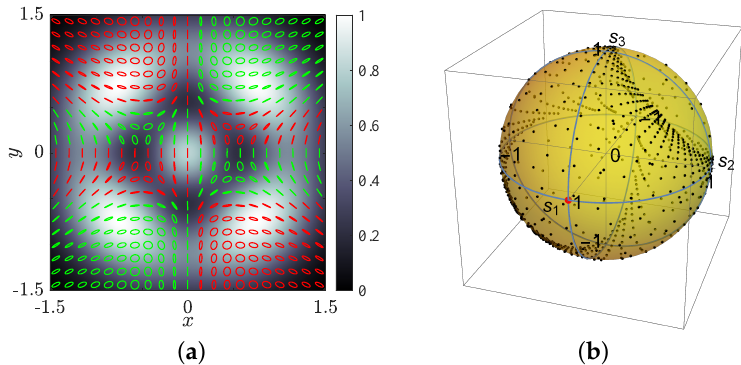
Figure 2. ( a ) Transverse intensity and polarization pattern for the field in Equation (10) where handedness is codified by the color of the ellipses (green = right, red = left, and red is also used for linear polarization), and distances are normalized to the beam spot size; ( b ) corresponding states of polarization represented by black dots on the Poincaré sphere; the red dot indicates horizontal linearly polarized